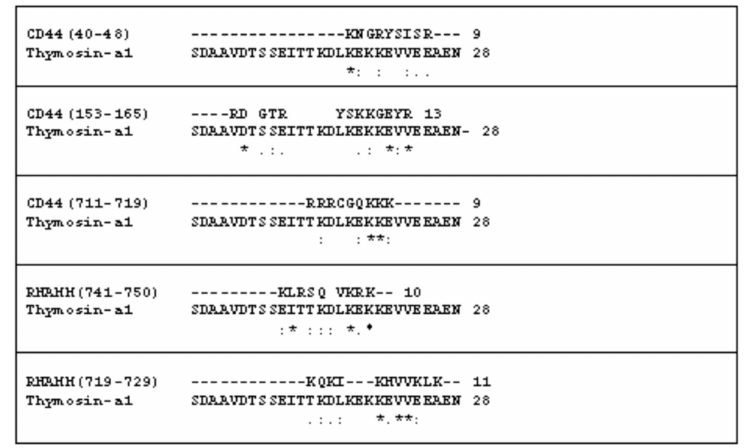
Figure 1. Sequence comparison between the residues of Thymosin α 1 and the common hyaluronan binding motifs of both CD44 (Mouse) and RHAMM (Mouse) as reported [48]. The symbols ( * ), ( . ) and ( : ) indicate identity, similarity and high similarity respectively between individual